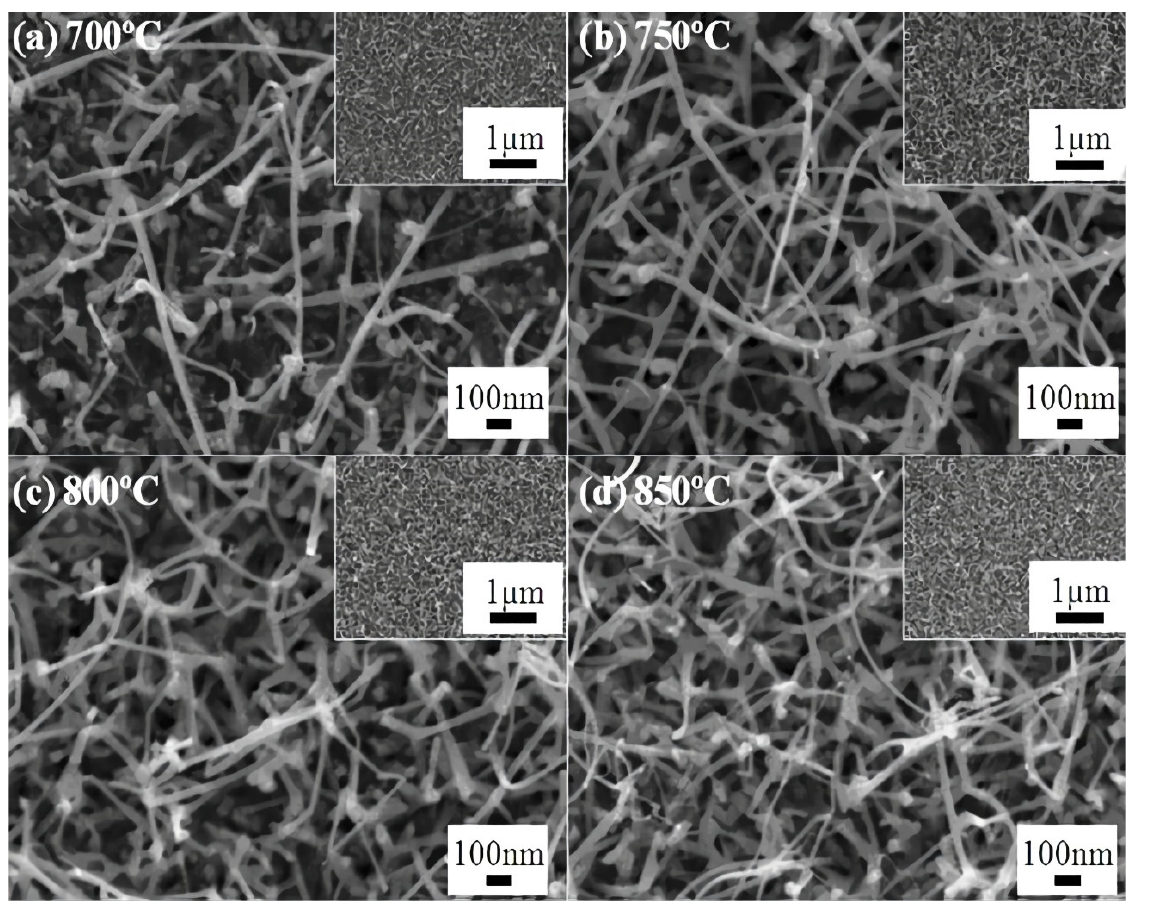
Figure 9. FE-SEM images of gallium oxide nanowires synthesized by pulse laser deposition using gold catalyst with varying temperatures. ( a ) 700 °C; ( b ) 800 °C; ( c ) 850 °C; ( d ) 900 °C [142]. “Reprinted with permission from Ref. [142]. Copyright (2012), Scientific Research”.